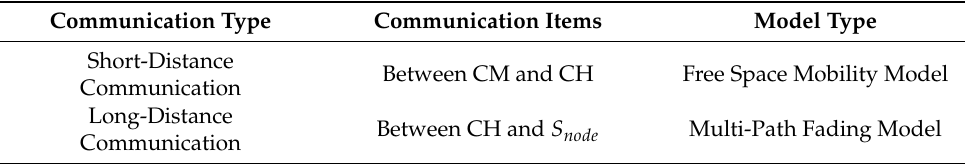
Table 3. Communication